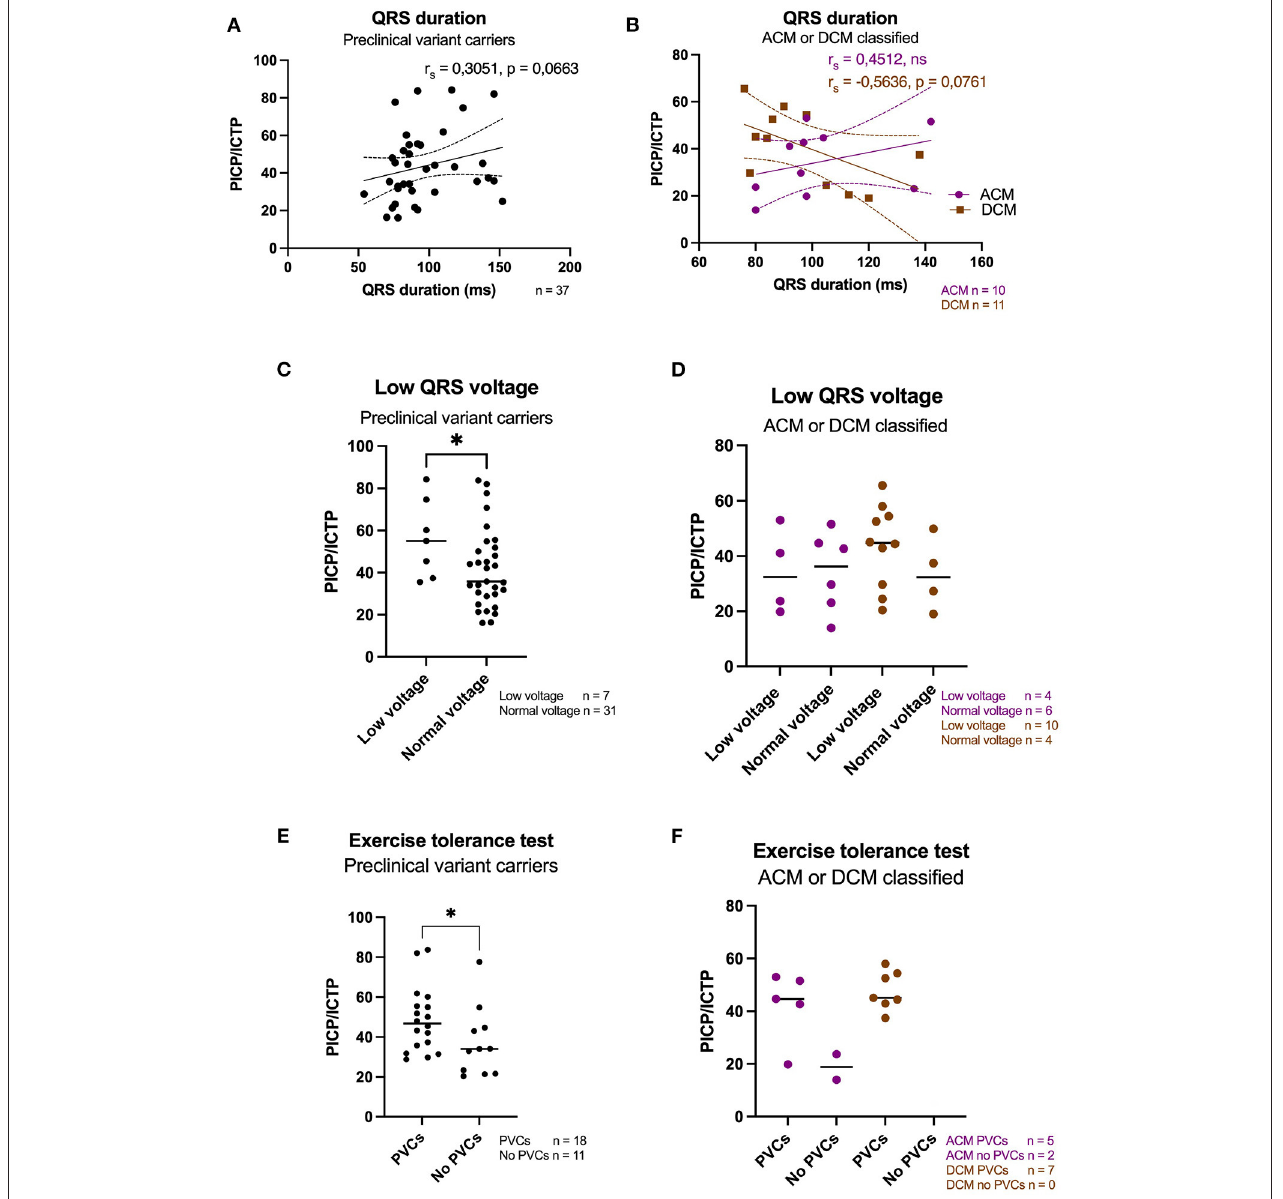
FIGURE 3 | Subpoulation analysis of electrical parameters. (A) A weak positive correlation was found with QRS duration in preclinical pathogenic variant carriers ( n = 37). (B) A moderate positive correlation was found with QRS duration in patients diagnosed with ACM ( n = 10), while a moderate negative correlation was found with QRS duration in DCM diagnosed patients ( n = 11). (C) A significant higher PICP/ICTP ratio was found in preclinical variant carriers that presented with low QRS voltages. (D) No significant difference was found in ACM or DCM diagnosed PLN patients with total collagen turnover and the presence of low QRS voltages. (E) A significant higher PICP/ICTP ratio was found when PVCs were detected during an exericse tolerance test in preclinical variant carriers. (F) No signficant difference was found in PICP/ICTP ratios and the detection of PVCs in ACM or DCM classified PLN patients. Of note, all DCM patients presented with PVCs during an exericse tolerance test ( n = 7). ACM, arrhythmogenic cardiomyopathy; DCM, dilated cardiomyopathy; PVCs, premature ventricular contractions; PICP, procollagen type I carboxy-terminal pro-peptide; ICTP, C-terminal telopeptide collagen type I; rs, Spearmann’s rho. * p <